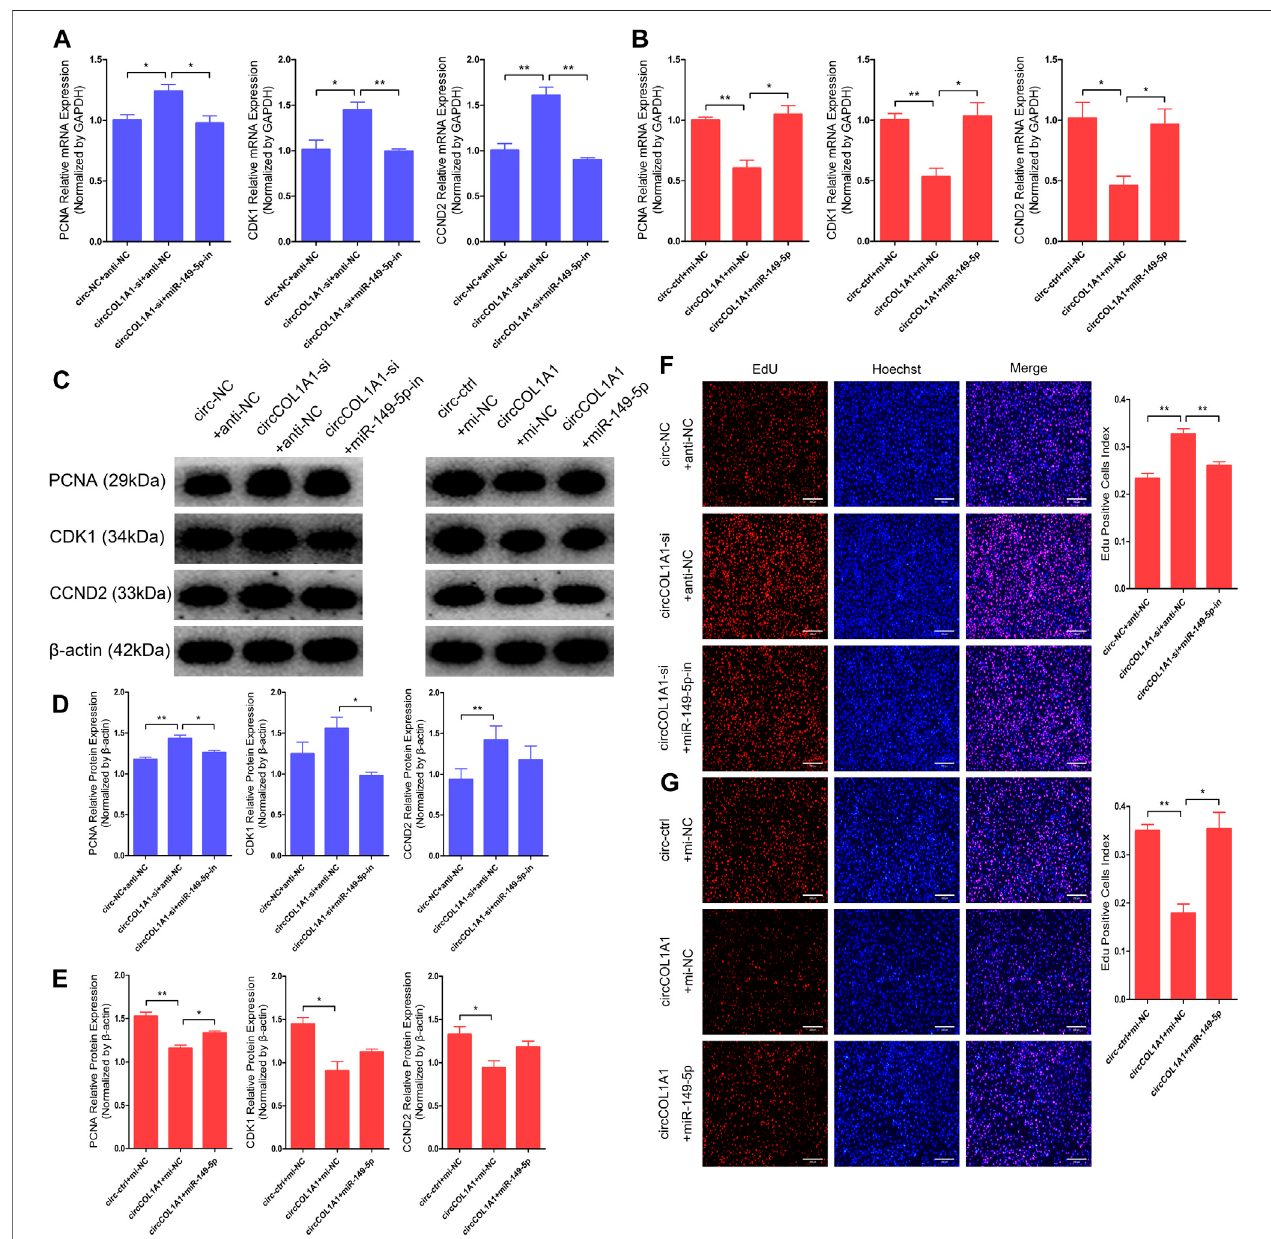
FIGURE 7 | Effects of circCOL1A1 and miR-149-5p cotransfection on the proliferation of goat hair follicle stem cells. (A) The relative expression of proliferation markers (PCNA, CDK1, and CCND2) at 48 h after hair follicle stem cells were co-transfected with circCOL1A1-si (siRNA-3) and miR-149-5p-in (inhibitors). (B) The relative expression of proliferation markers after 48 h in stem cells co-transfected with circCOL1A1 (overexpressing plasmid) and miR-149-5p (mimics). (C,D) Protein expressionofproliferationmarkersafter48 hinstemcellsco-transfectedwithcircCOL1A1-siandmiR-149-5p-in. (C,E) Proteinexpressionofproliferationmarkers after48 hinstemcellsco-transfectedwithcircCOL1A1andmiR-149-5p. (F,G) RepresentativeimagesoftheEdUassayat48 haftercircCOL1A1-siandmiR-149-5p-in cotransfection (F) and circCOL1A1 and miR-149-5p cotransfection (G) . Bars, 200 µm. (H,I) The cell cycle distribution was detected at 48 h after cotransfection with circCOL1A1-si and miR-149-5p-in by the fl ow cytometry assay. (J, K) The cell cycle distribution was detected at 48 h after cotransfection with circCOL1A1 and miR- 149-5p by the fl ow cytometry assay.